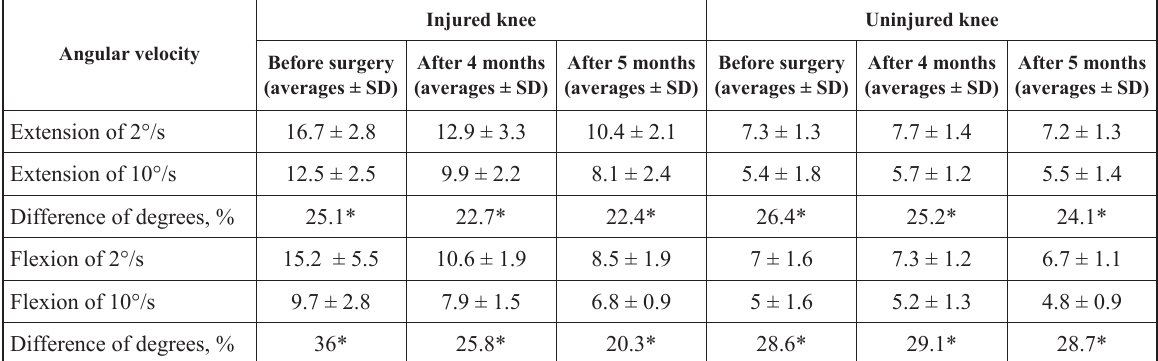
Angular velocity